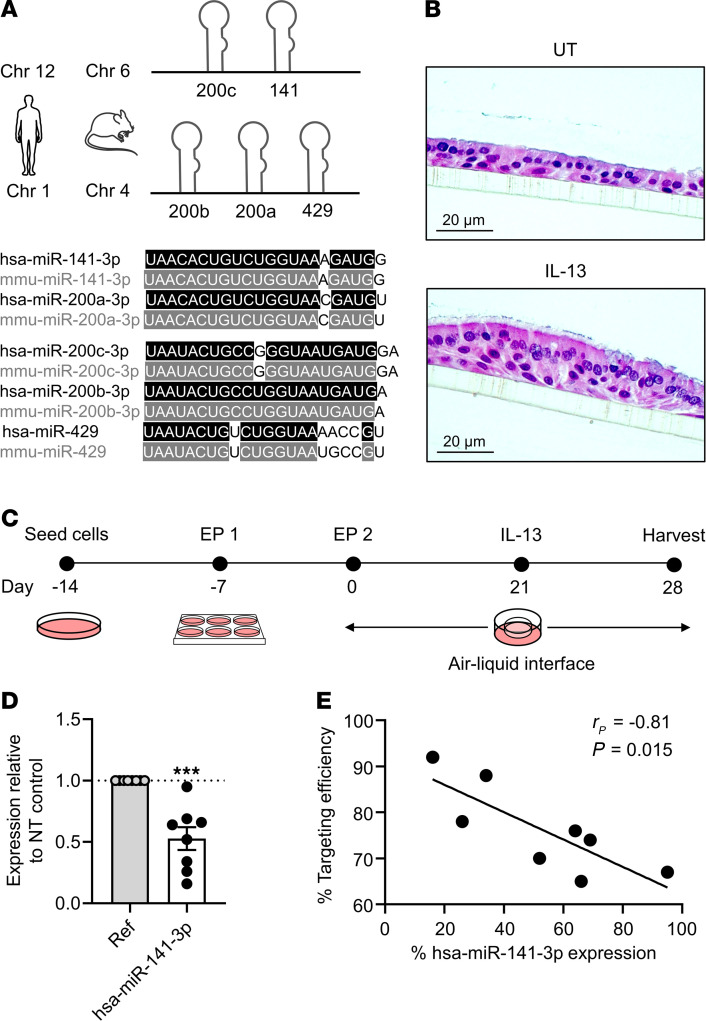
CRISPR/Cas9-mediated knockdown of miR-141 in primary HBECs grown at air-liquid interface.(A) Mature miRNA sequences and genomic location of the miR-141/200 family in humans and mice. (B) Representative H&E-stained filter sections of human bronchial epithelial cells (HBECs) cultured at air-liquid-interface (ALI) under untreated (UT) conditions or IL-13 stimulation, harvested on day 28 (representative of 4 unique donors). Scale bar: 20 μm. (C) Electroporation-based (EP-based) CRISPR/Cas9 protocol established in an in vitro ALI system (days 0–28, ± IL-13 on days 21–28) using HBECs. (D) Expression level of hsa-miR-141-3p by TaqMan qPCR following administration of MIR141-targeting versus nontargeting (NT) gRNAs normalized to reference miRNAs hsa-miR-103a-3p and hsa-miR-191-5p (Ref) (n = 8, 2-tailed t test; ***P < 0.001). (E) Correlation of MIR141-targeting efficiency score assessed by Sanger DNA sequencing and ICE Synthego analysis and hsa-miR-141-3p expression levels by qPCR. rP, Pearson correlation coefficient.